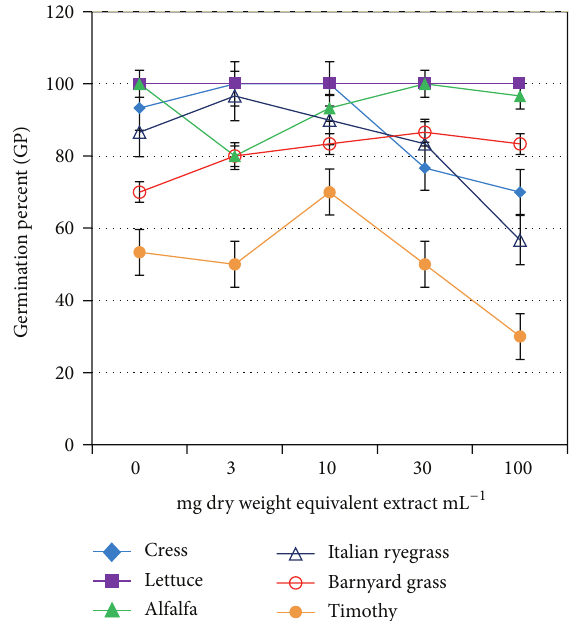
Figure 3: Effect of aqueous methanol extracts of O. tenuiflorum on CRGofdifferentplantspeciesatfourdifferentconcentrations.Other details are the same as Figure 1.